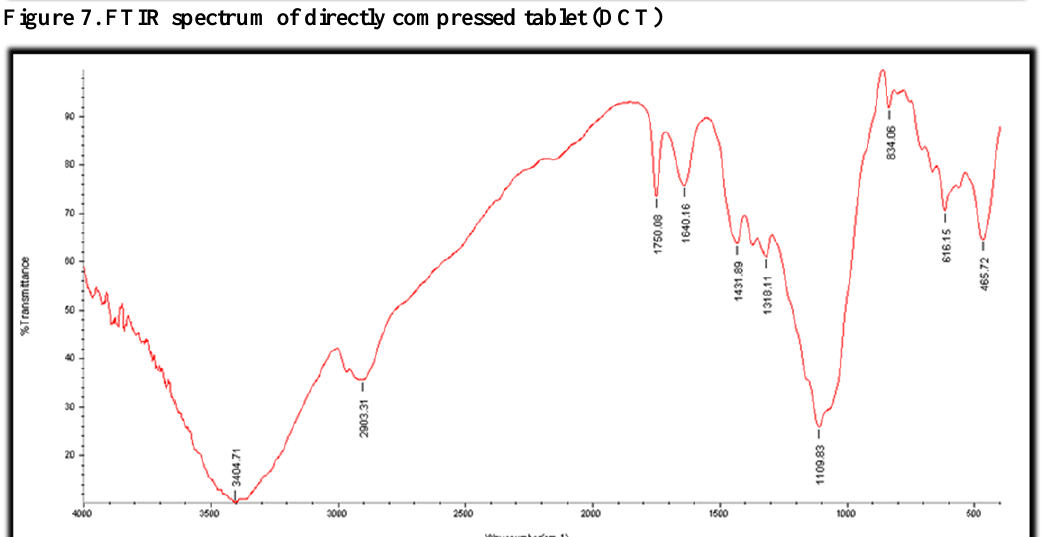
Figure 8.FTIR spectrum of liquisolid compact formula